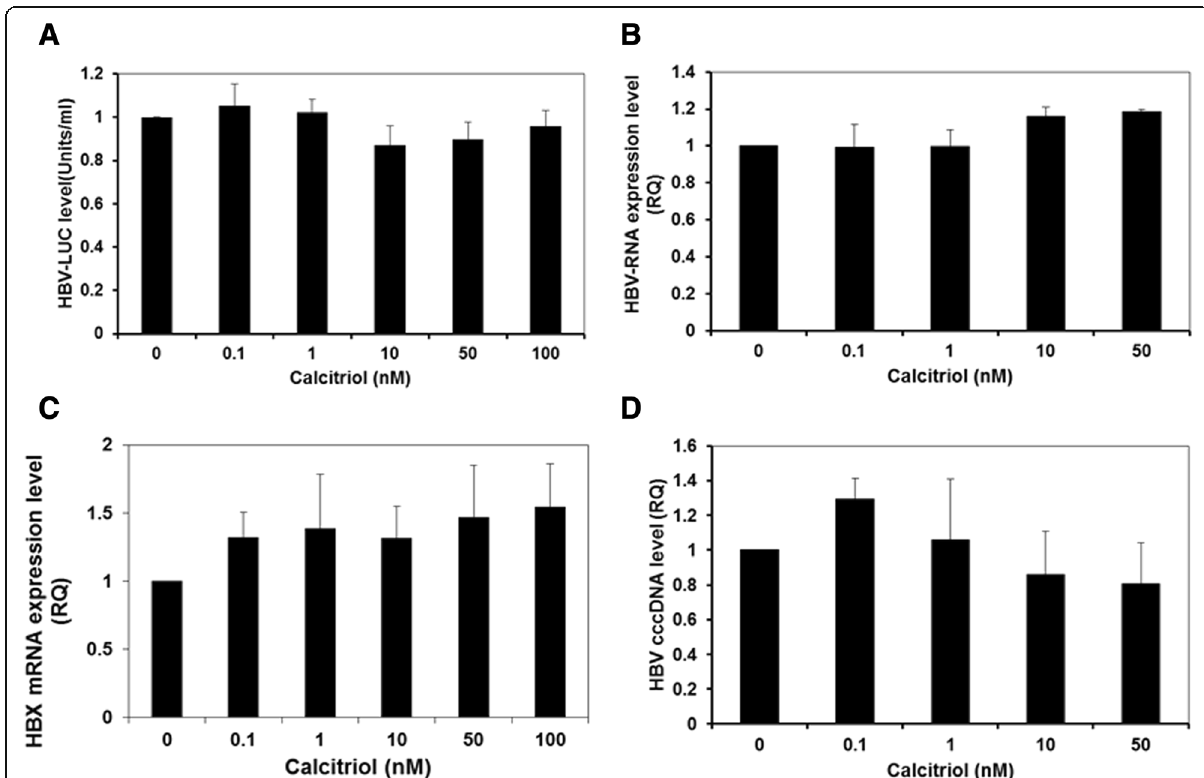
Fig. 1 Treatment with increasing concentrations of Calcitriol does not affect the transcription and expression levels of HBV genes and cccDNA. HepG2 cells were transfected with the 1.3 X HBV-Luc plasmid. 24 h later, the cells were treated with increasing concentrations of Calcitriol or EtOH, as a control. After an additional 24 h, the cells were harvested and analyzed for Luciferase activity ( a ). HBV-RNA ( b ), HBX ( c ) and cccDNA ( d ) were measured using RT-PCR. Results are expressed as mean ± standard